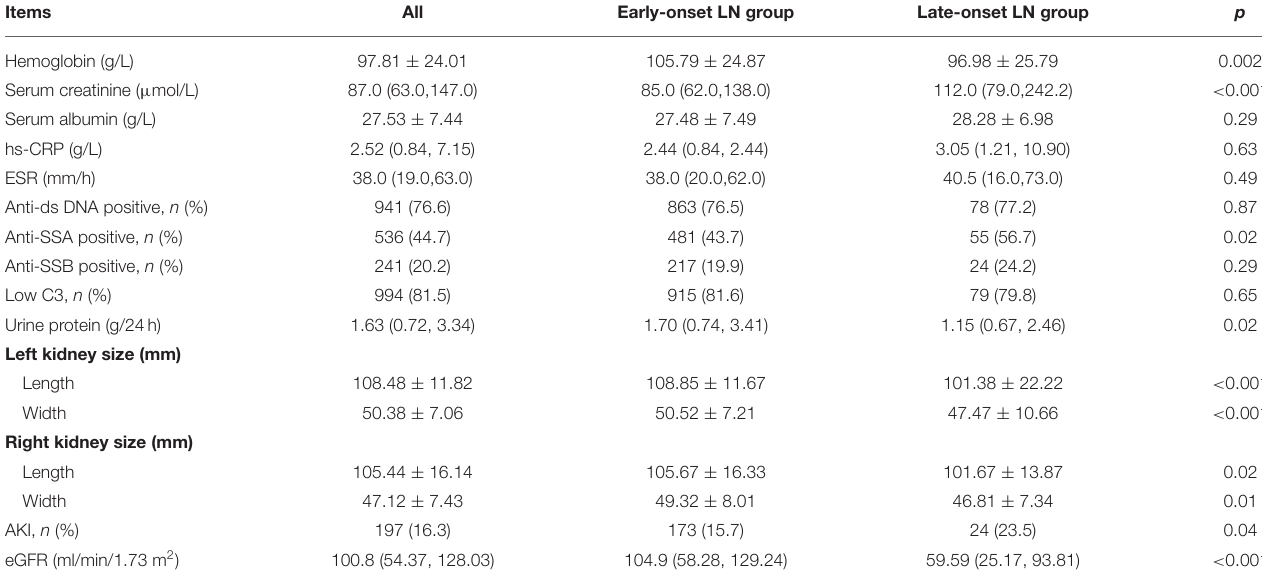
TABLE 2 | Comparisons of baseline examination profiles between late- and early-onset LN groups. Items